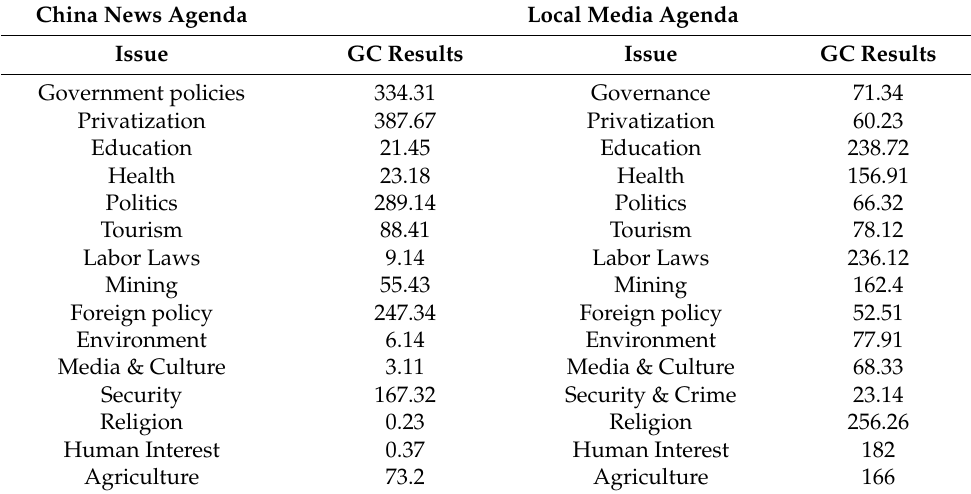
Table 2. Granger test causality on salient issues.